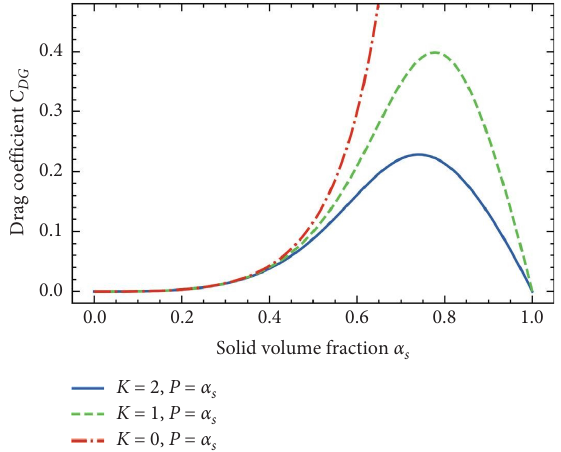
Figure 4: Drag coefcient curves with diferent constant mass fuxes ( ρ s � 1800kg/m 3 and ρ f � 1100kg/m 3 ) given by the enhanced generalized drag model of Pudasaini